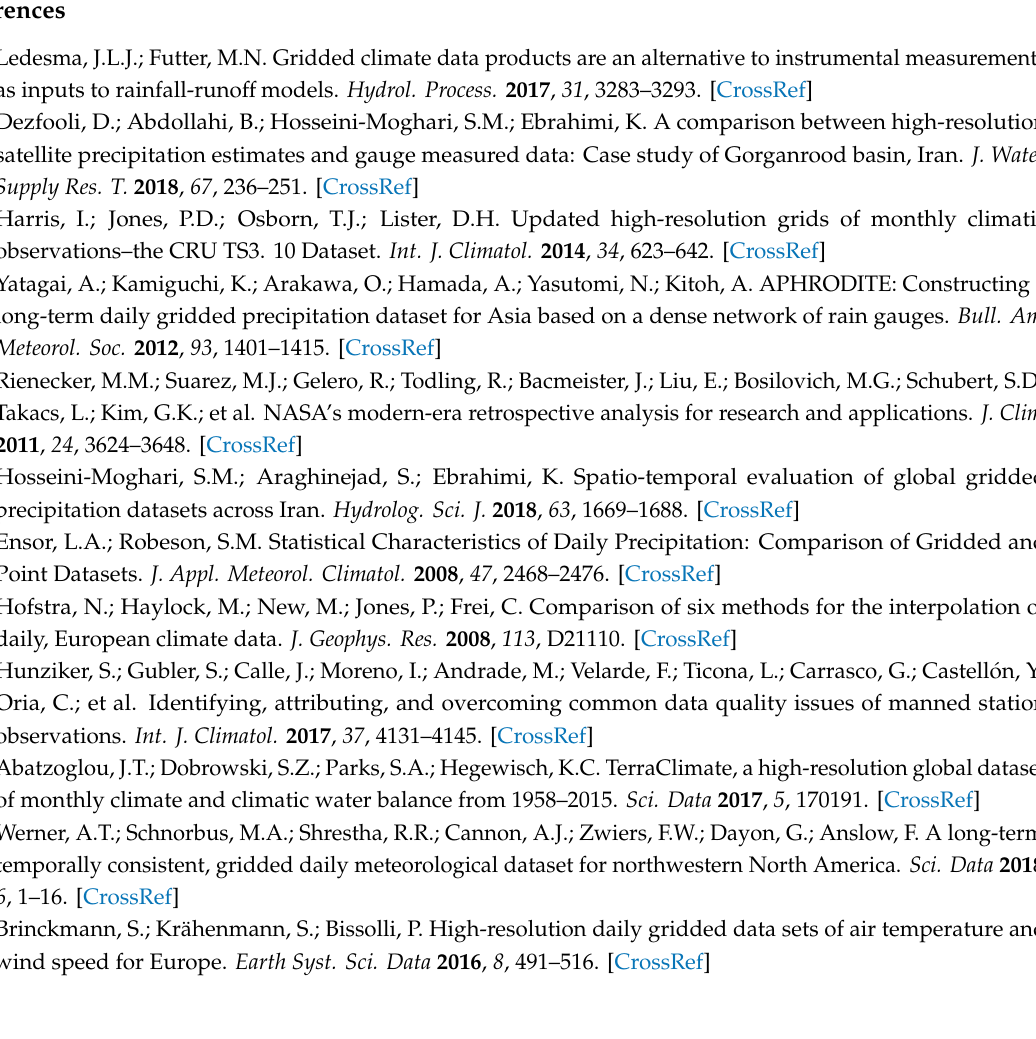
Figure S1: Mean monthly maximum temperature ( ◦ C) of OBS at observed station points during 1988 to 2012, Figure S2: Mean monthly maximum temperature ( ◦ C) of Princeton dataset at observed station points during 1988 to 2012, Figure S3: Mean monthly minimum temperature ( ◦ C) of OBS at observed station points during 1988 to 2012, Figure S4: Mean monthly minimum temperature ( ◦ C) of Princeton dataset at observed station points during 1988 to 2012, Figure S5: Ratios of monthly observed wind speed to Princeton during 1988 to 2012 over Iran, Table S1: Information about the climate